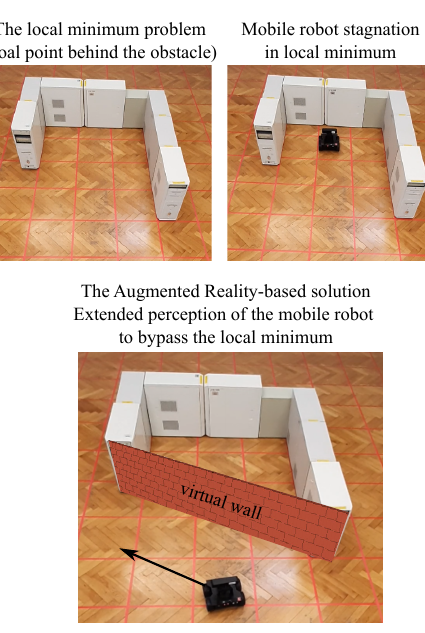
Figure 1. AR-APF algorithm idea visualization.